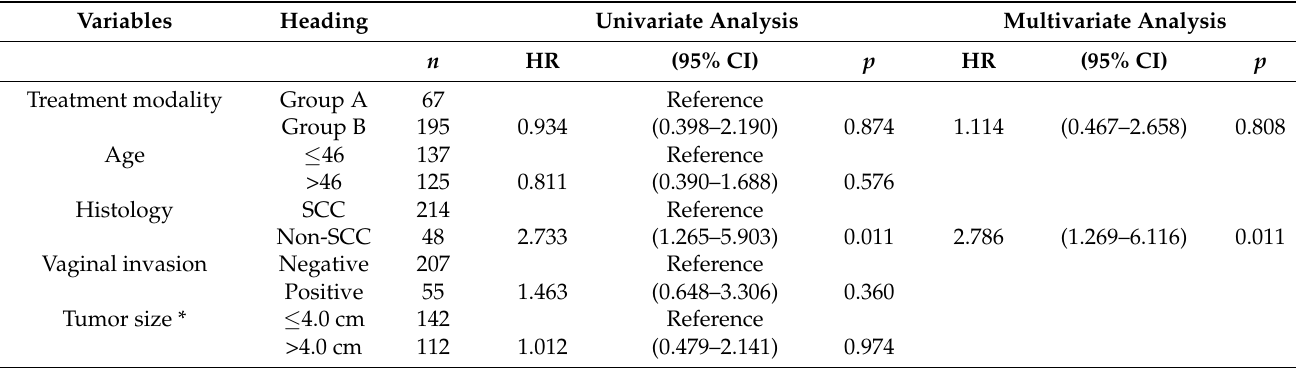
Figure 2. Kaplan-Meier estimates of ( A ) overall survival curves and ( B ) disease-free survival curves between definitive chemoradiotherapy (group A) and upfront radical hysterectomy followed by tailored adjuvant therapy (group B) in pro- pensity score matching cohort. Table 2. Univariate and multivariate analysis of factors for overall survival.